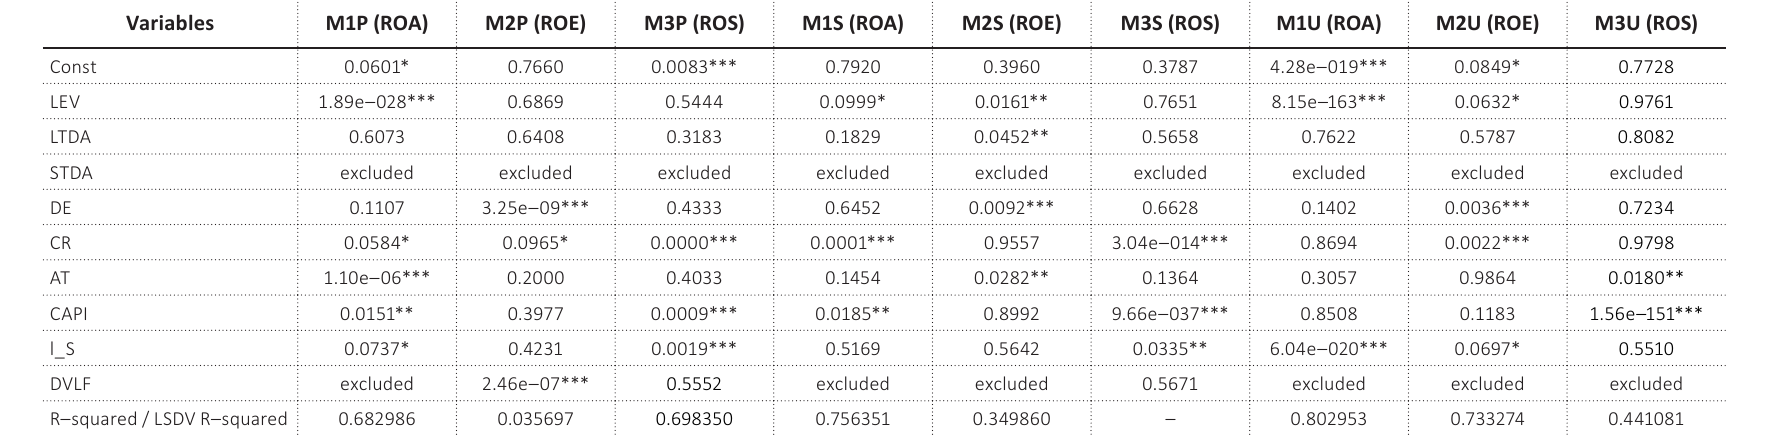
Source: Calculated using the Gretl software